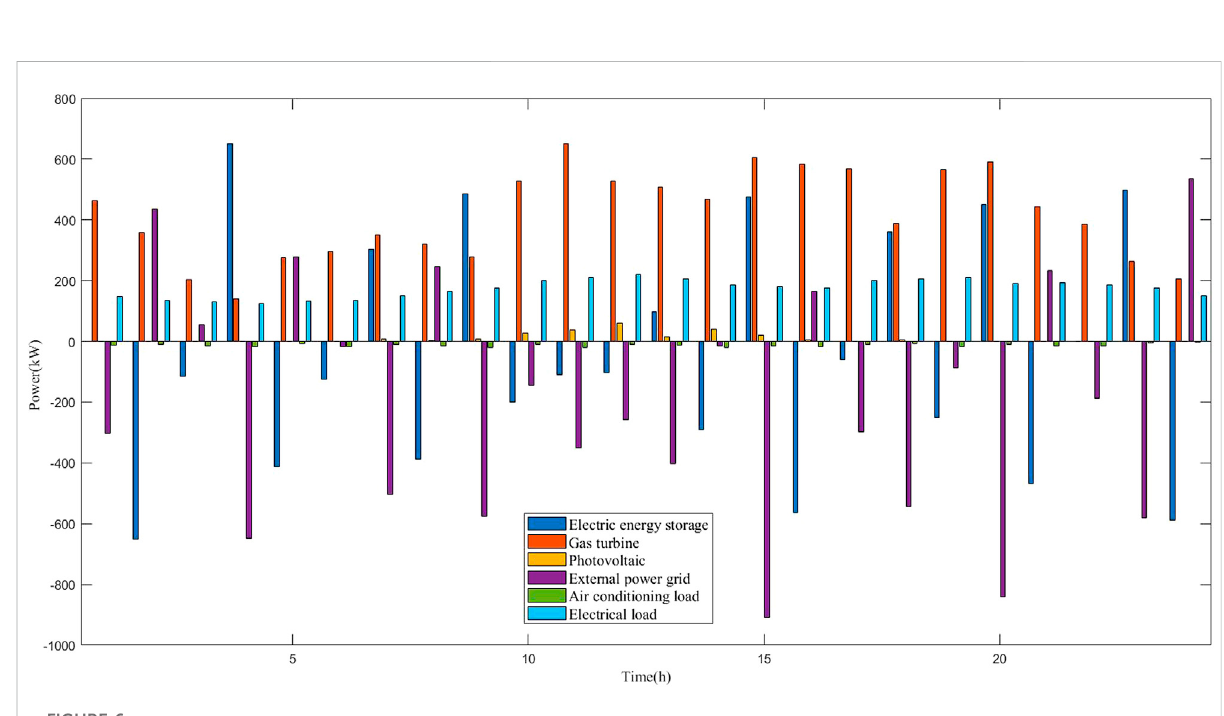
FIGURE 5 Optimization results of cooling load under Case 1.